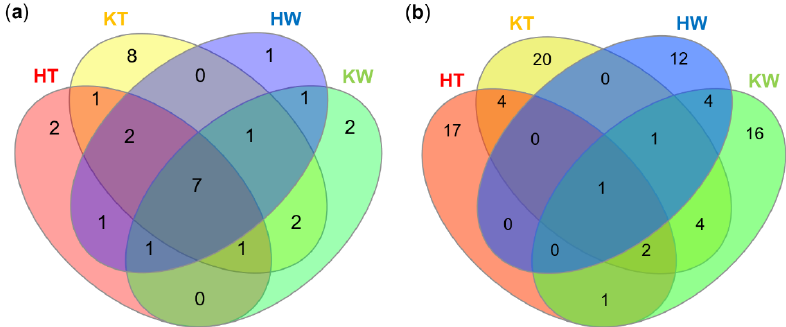
Figure 2. Venn diagrams showing the number of shared and exclusive microbial taxa across sample types and sampling locations. The distribution of taxa is given for microbial orders ( a ) and genera ( b ). H, Helgoland; K, Kiel; T, Tunic; W, Seawater. Microorganisms 2020 , 8 , x FOR PEER REVIEW